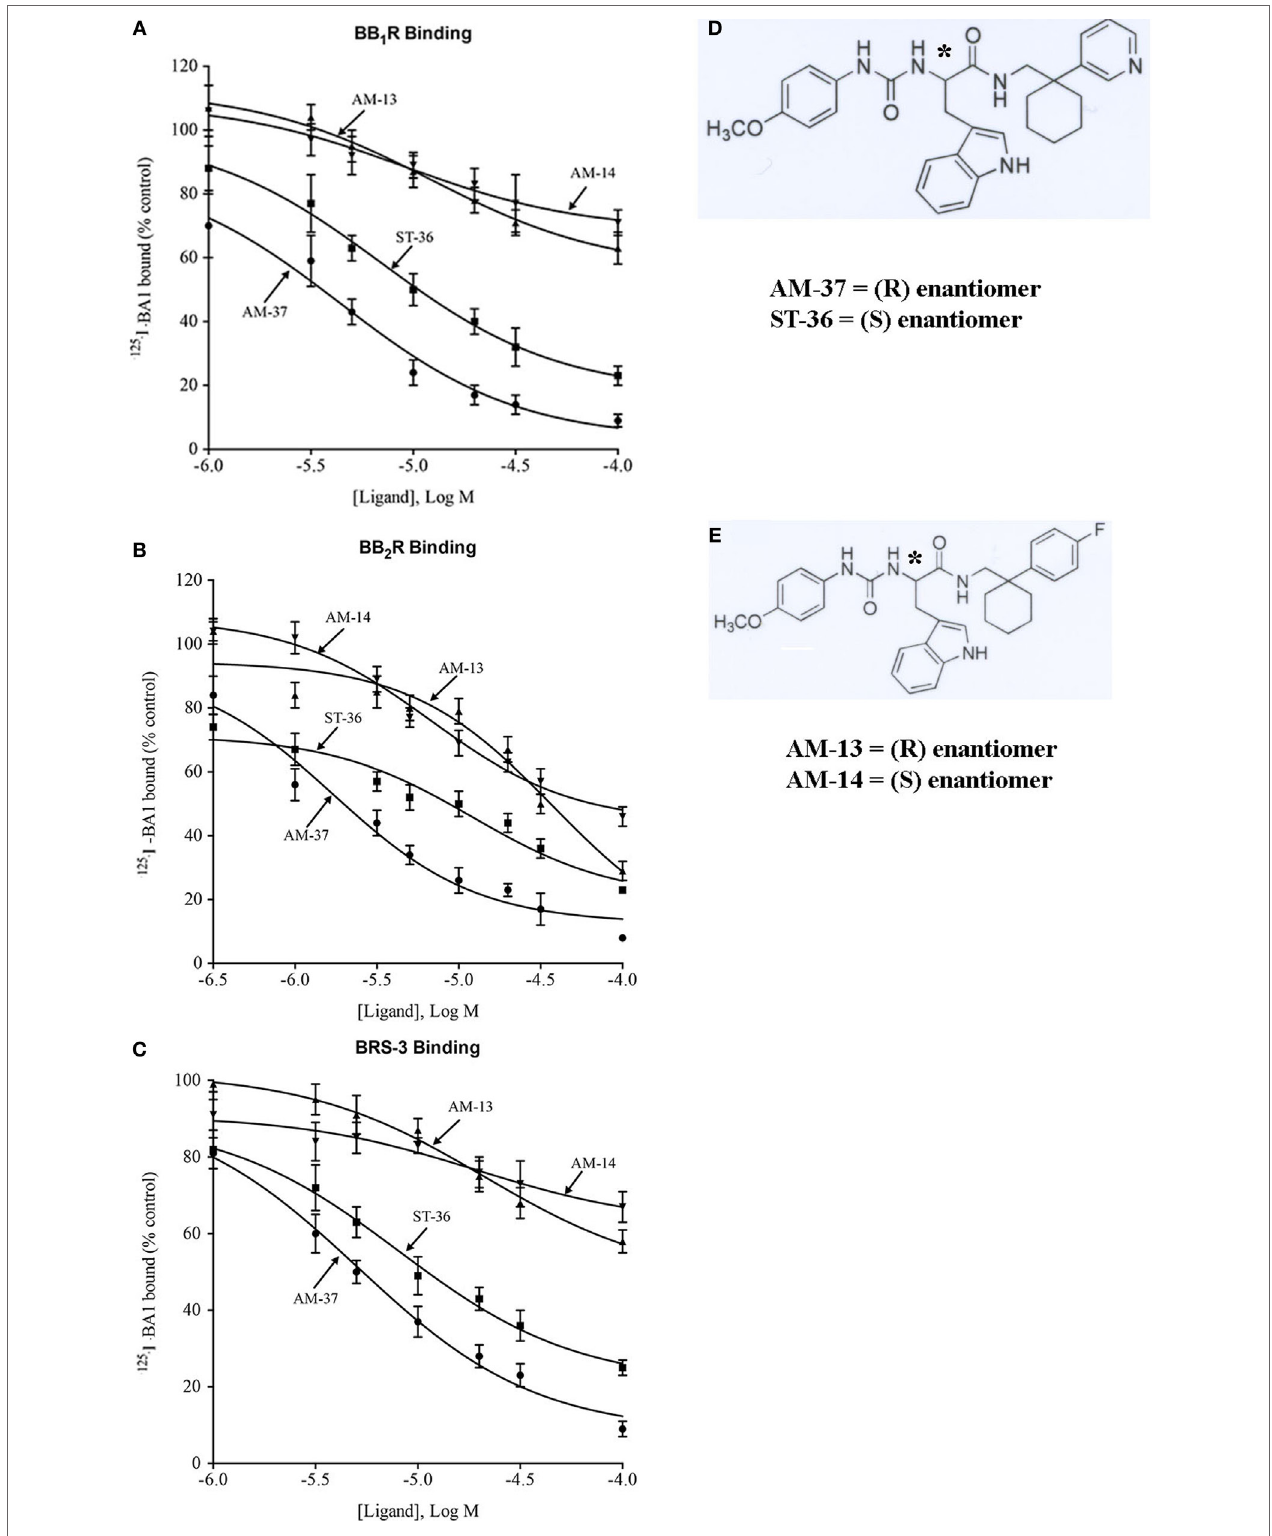
FigUre 1 | Binding. The ability of varying concentrations of AM-37 ( ⚫ ), ST-36 ( ◾ ), AM-13 ( ▴ ), and AM-14 ( ▾ ) to inhibit specific 125 I-BA1 binding was investigated using (a) BB 1 R-, (B) BB 2 R-, and (c) BRS-3-transfected NCI-H1299 cells. The mean value ± SD of three determinations each repeated in duplicate is shown. (D) The structure of AM-37 and ST-36 is shown. (e) The structure of AM-13 and AM-14 is shown; *indicates the optically active